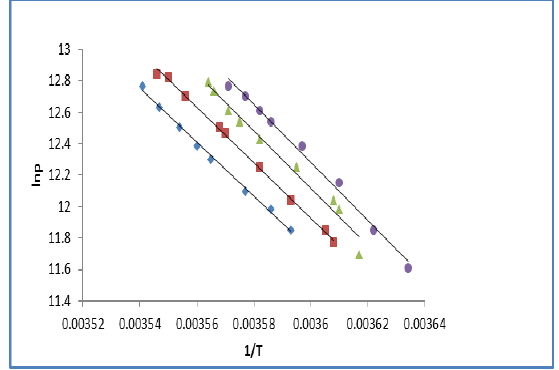
Fig.12. The logarithms of the dissociation pressures (ln P) versus (1/T) along R134a(V)− liquid water (Lw)−hydrate (H) in the presence and absence NaCl coexistence lines ♦ without salt; ■ 0.09 mol ̸ kg; ▲ 0.17 mol ∕ kg; ● 0.26 mol ∕